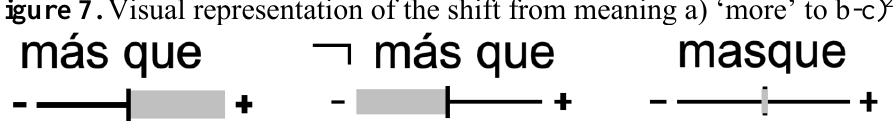
Figure 7. Visual representation of the shift from meaning a) ‘more’ to b-c)